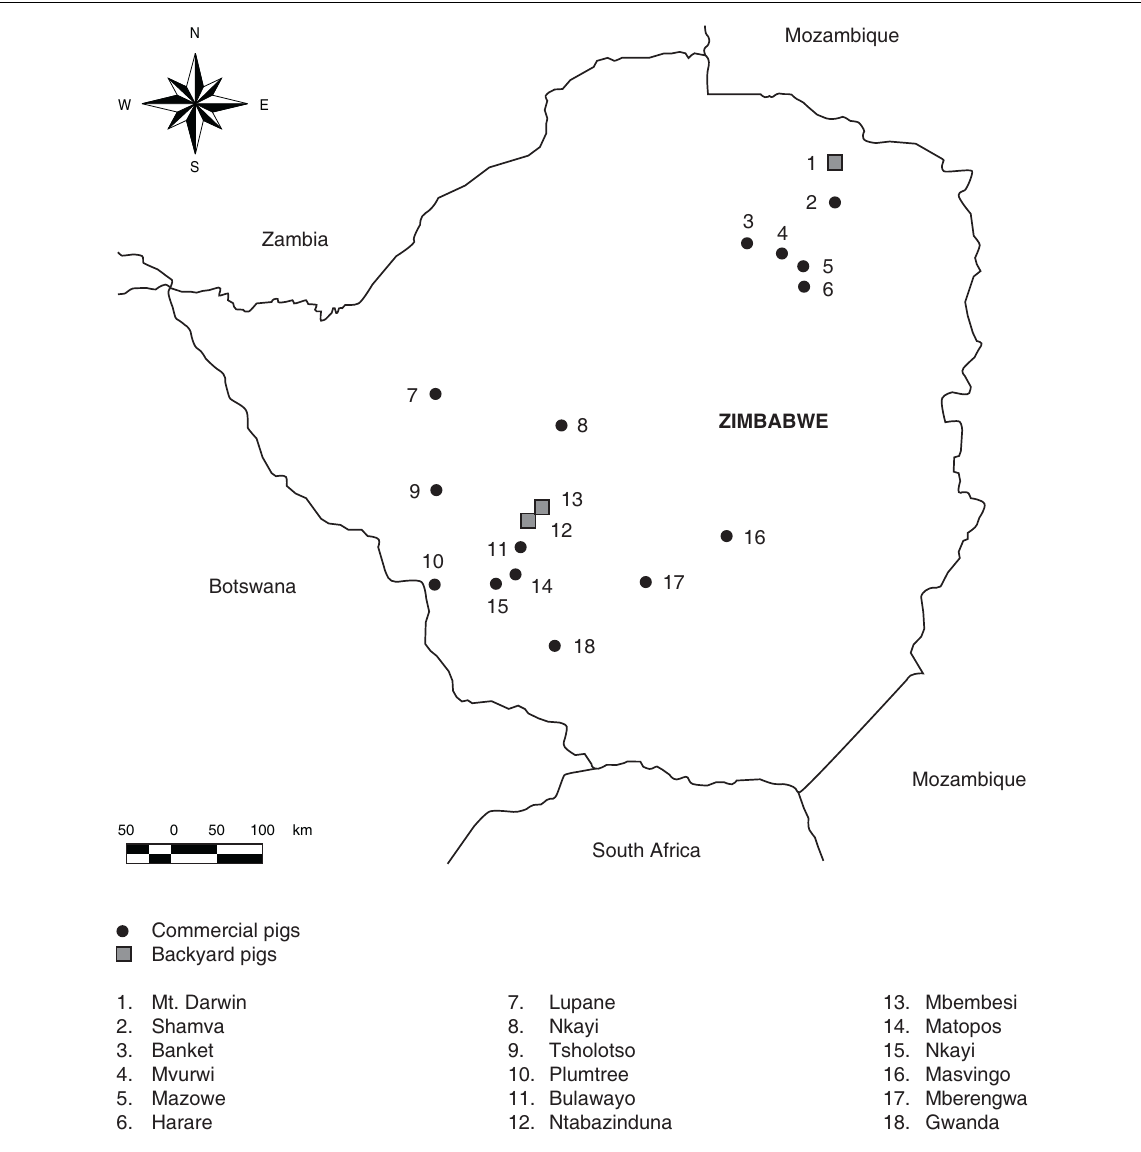
Abattoir III (13.2%) and backyard herds (16%) than from commercial properties (fattening pigs: 4.3 %; adult pigs: 0 %) had titres > 1:400. The comparison of seroprevalence rates among the different categories varied depending on the cate- gories concerned and so did a comparison of the number of positive animals at each individual anti- body titre (1:100, 1:200 and > 1:400) either overall or among categories. Chi-square tests of the com- bined antibody positive samples by individual titre showed significant differences in the proportion of positives at all possible titre comparisons: 100 vs.